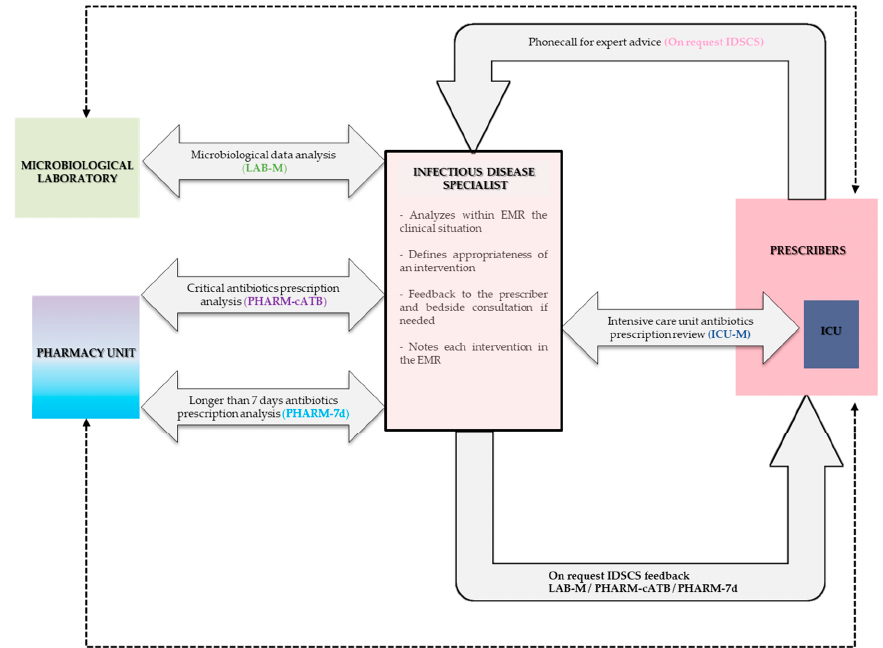
Figure 7. Antibiotic stewardship program organization in the studied hospital when fully established in December 2018. Dotted lines represent pre-existent relationship before implementation of the